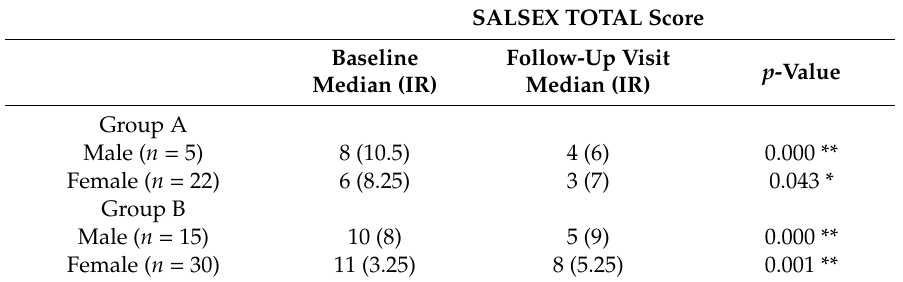
Table 2. Gender di ff erences. Global SALSEX score of groups A and B, at baseline and follow-up. Table 2. Gender differences. Global SALSEX score of groups A and B, at baseline and follow-up. SALSEX TOTAL Score